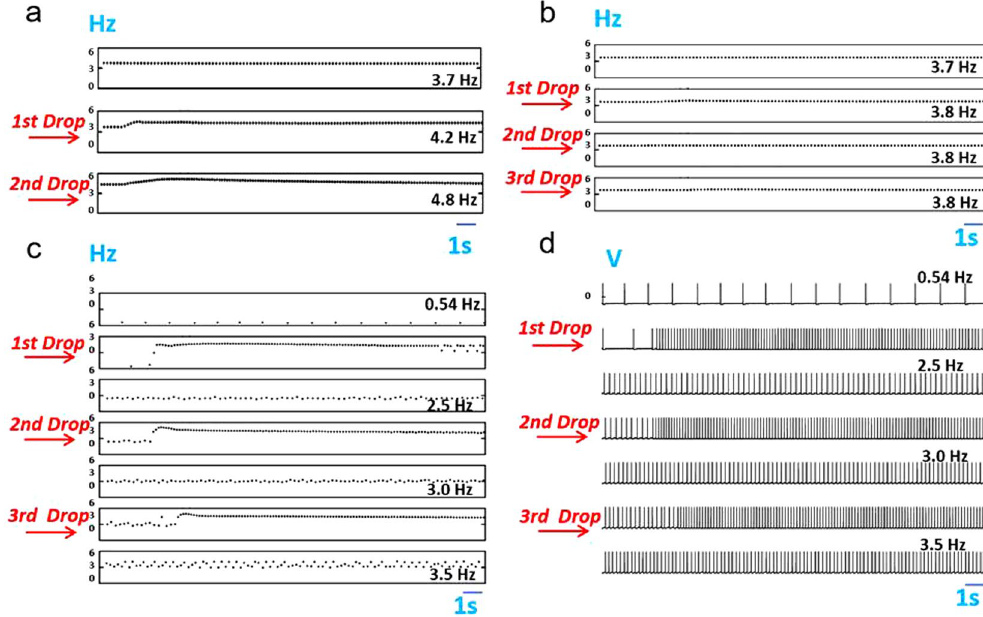
Figure 4. Instantaneous frequency of output pulses generated by the bioinspired glucose nanobiosensor during glucose detection. ( a ) The pulse frequency elevation was induced by sufficient amount of glucose. (0.5 mM glucose in each drop): after each drop, the total resistance of the type II cell attached to the amperometric glucose biosensor is changed and this increases the output frequency. ( b ). PBS test and analysis of selectivity of the bioinspired nanobiosensor to glucose by adding a 2-ml, 2-ml, and 4-ml PBS solution as the first, second, and third drop, respectively. ( c ) Continuous successive addition of glucose to the electrochemical cell to record the alteration of the pulse frequency (0.5 mM glucose in each drop) ( d ) Pulse frequency was modulated by detection limit amount of glucose, including the alternating frequency (0.5 mM glucose in each drop).